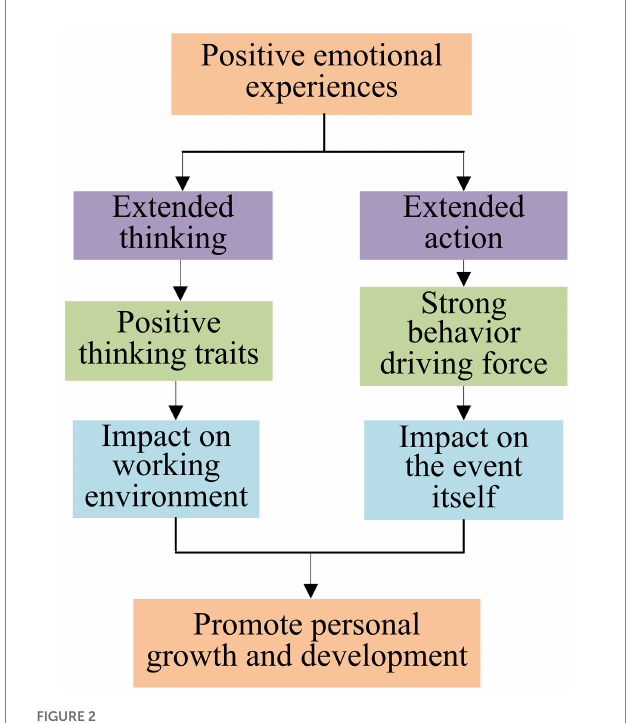
FIGURE 2 An extended theory of positive